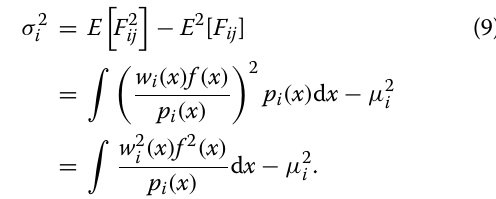
Table 1 Naming convention for the MIS estimators in this paper. We will drop the superindex 1 from primary estimators when